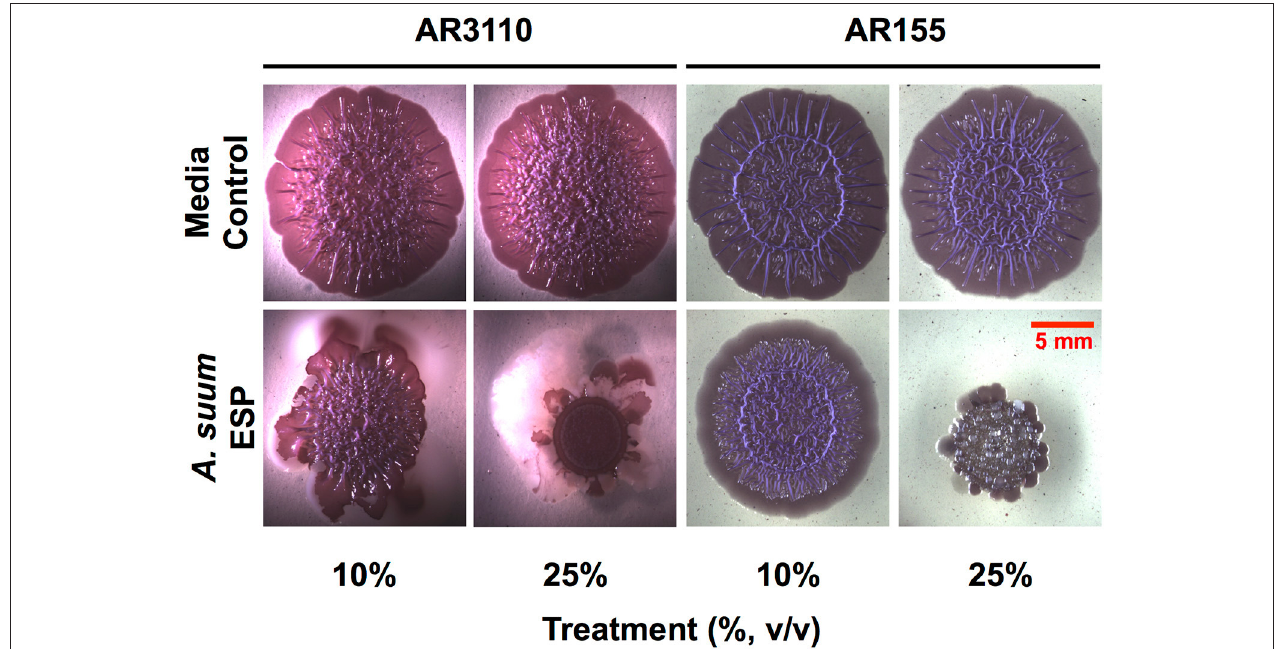
FIGURE 3 | Ascaris suum excretory/secretory products impair macrocolony biofilm formation. Five microliter of bacterial suspensions grown overnight were spotted on salt-free LB agar plates supplemented with Congo red, a dye that acs as an extracellular matrix indicator staining both pEtN-cellulose and curli fibers, as well as Coomassie brilliant blue and infused with either adult worm media (media control) or adult A. suum excreted/secreted products (ESP). Inoculated plates were then grown for up to 5 days at 28 ◦ C. Images shown here correspond to 5-days-old macrocolony biofilms of E. coli AR3110 and AR155 strains treated or untreated with A. suum ESP at two different